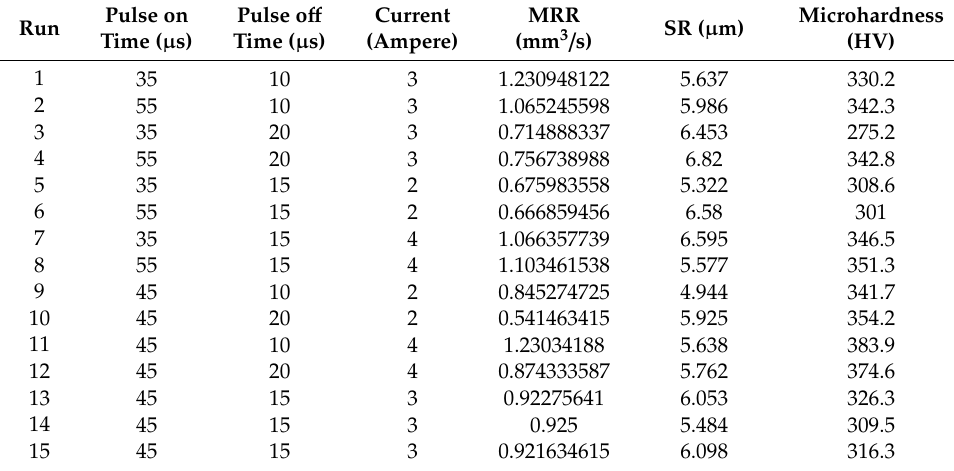
Table 3. Process parameters and their